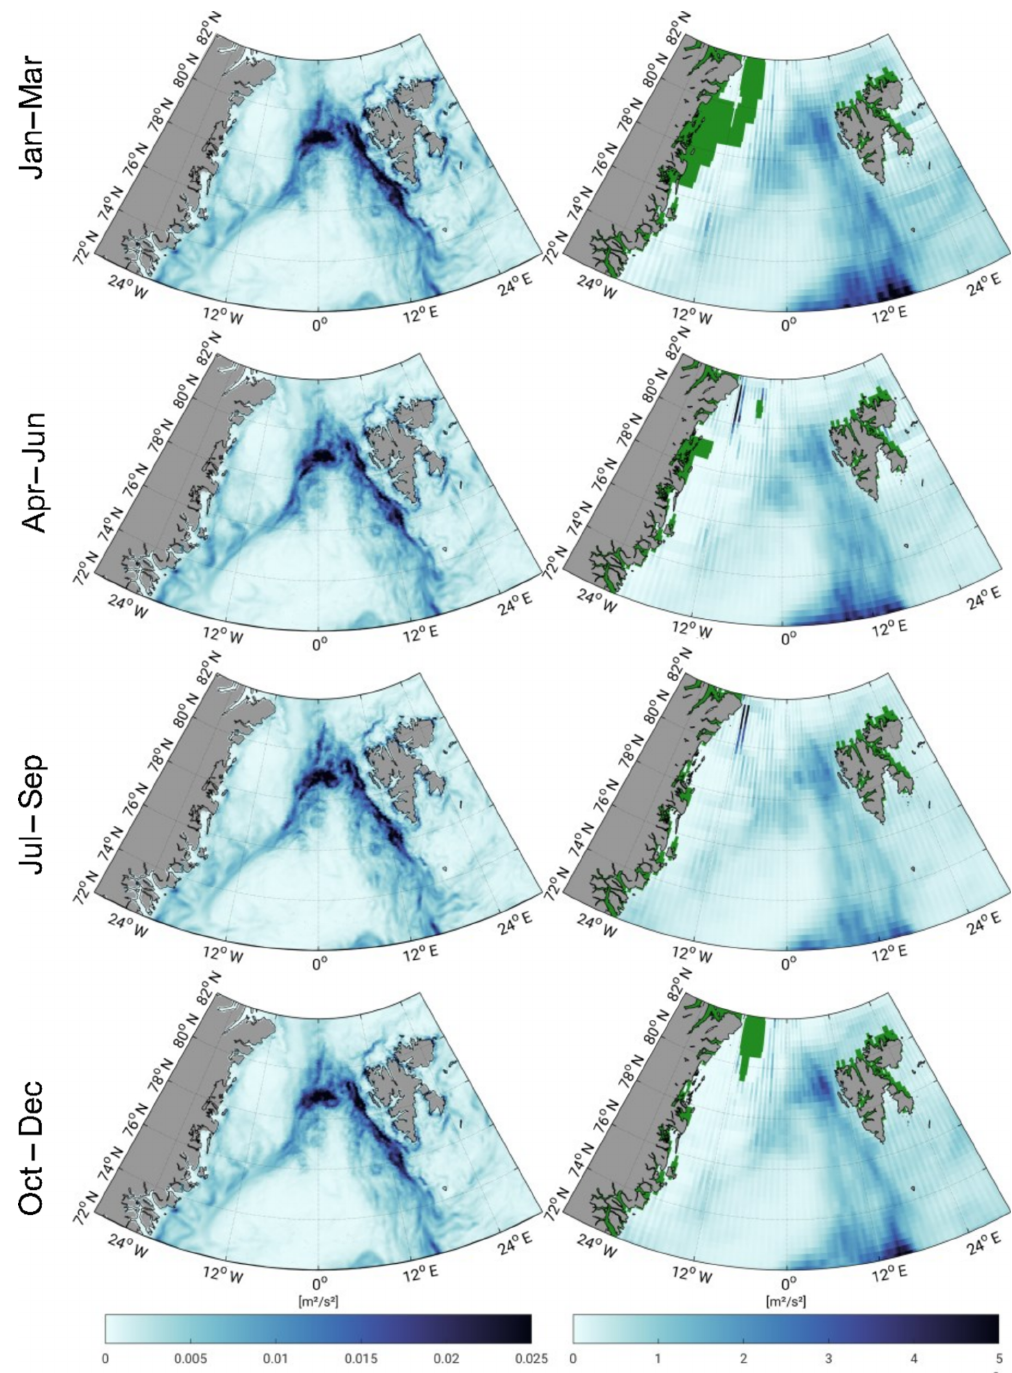
Figure 10. Three-monthly averaged geostrophic eddy kinetic energy within the FESOM period (1995–2012) for combined results (left) and ADT grids (right). Green areas indicate missing